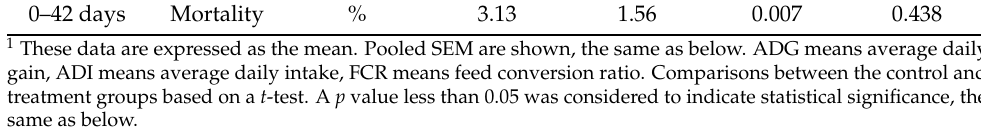
Table 2. Cont. Period Items Unit Control Treatment